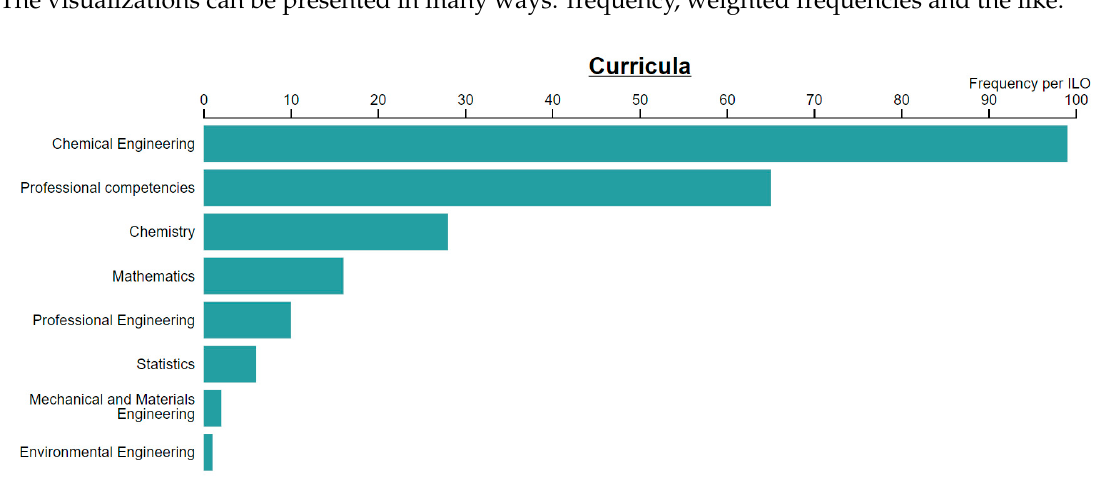
Figure 10. ILO frequencies for major knowledge domains across whole curriculum.